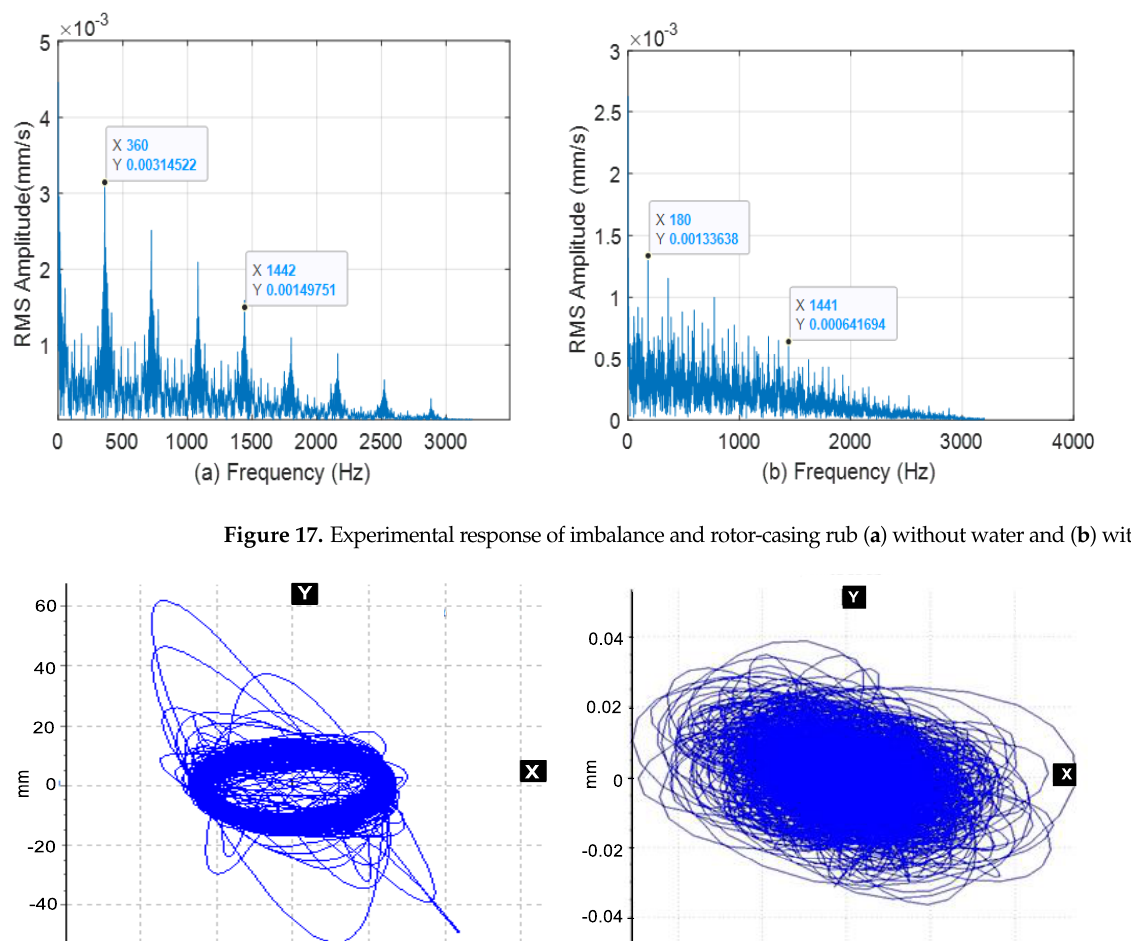
24 of 28 Figure 16. Experimental orbit response of the imbalanced drill string in fluid ( a ) without water and ( b ) with water . For the experiment presented, the drill string rotates in the air, and for the fluid, at a speed of approximately 1600 rpm with an imbalanced mass, the progressive excitation